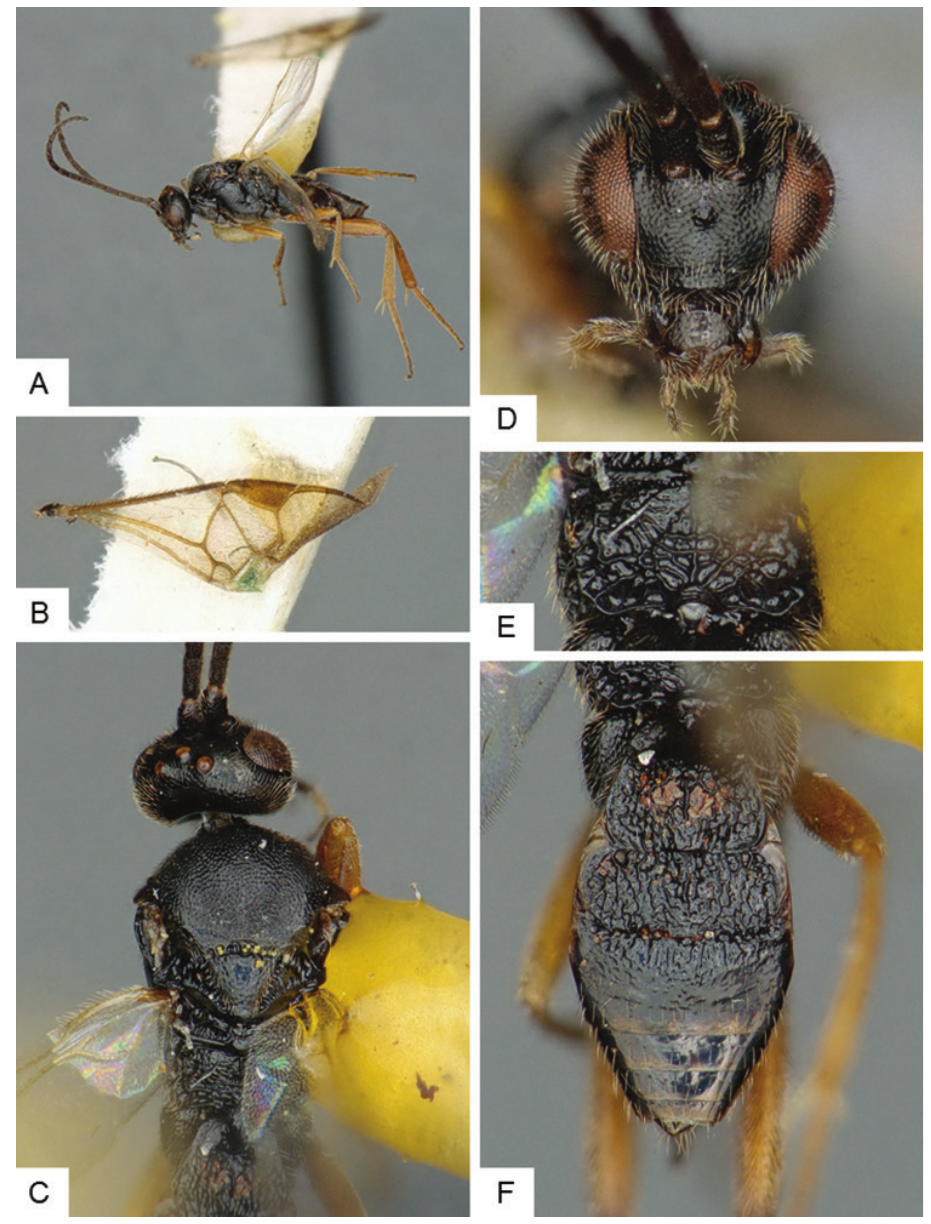
Figure 7. Cotesia yakutatensis . A Habitus, lateral B Fore wing C Head and mesosoma, dorsal D Head, frontal E Propodeum F Metasoma,